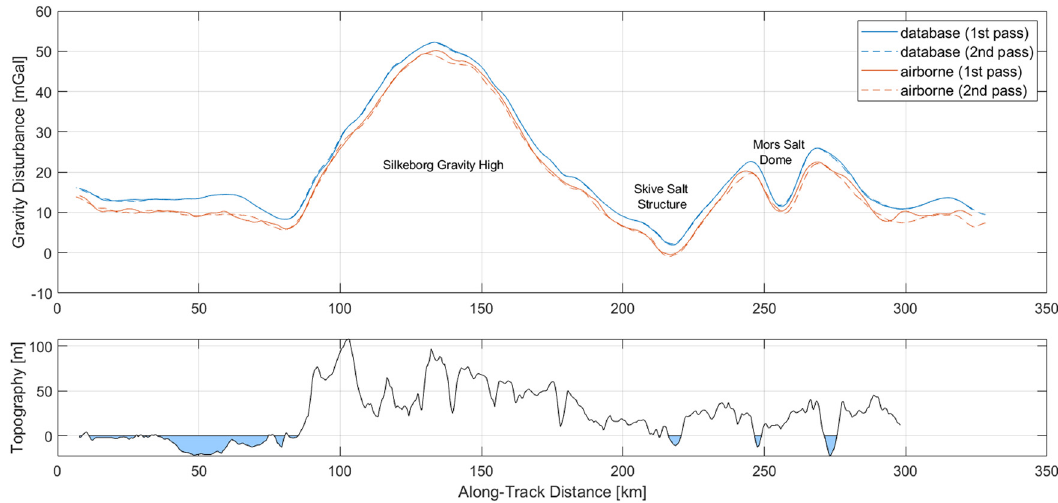
Figure 5: Gravity and topography along the pro fi le. ( Top ) Gravity disturbance from the fi rst and second fl ight pass. Blue lines are upward continued ground observations; red lines are airborne gravity estimates; ( Bottom ) Along - track topography from the 30 arc second Shuttle Radar Topography Mission ( SRTM30 ) data product ( Farr and Kobrick 2011 )